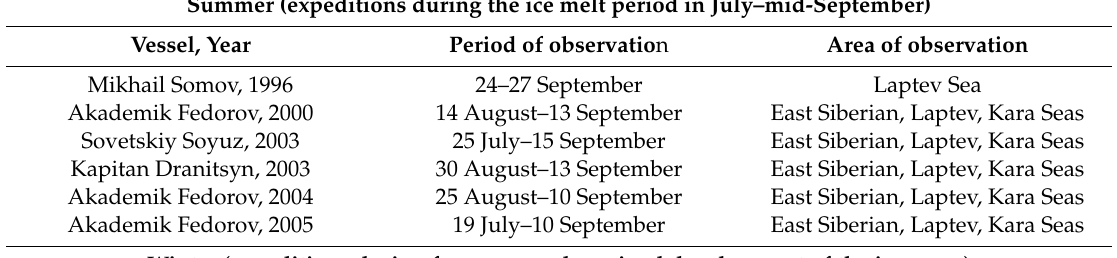
Table 1. Dates and periods of the expeditions that provided the ship